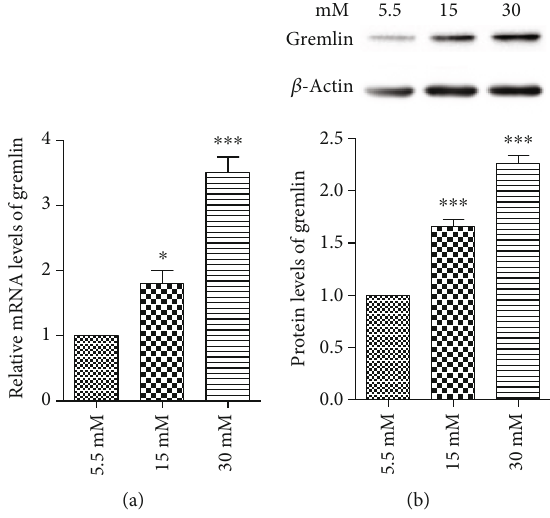
Figure 4: High glucose induced the expression of gremlin in RPE cells. The cells were exposed to normal glucose (5.5 mM) and high glucose (15 mM or 30mM) for 24 h. A real-time PCR and a western blot analysis illustrated that the (a) mRNA and (b) protein levels of gremlin were upregulated in response to high glucose compared with normal glucose. The data shown represent the mean ± SD of three independent experiments. ∗ p < 0 : 05 versus 5.5mM; ∗∗∗ p < 0 : 001 versus 5.5mM.